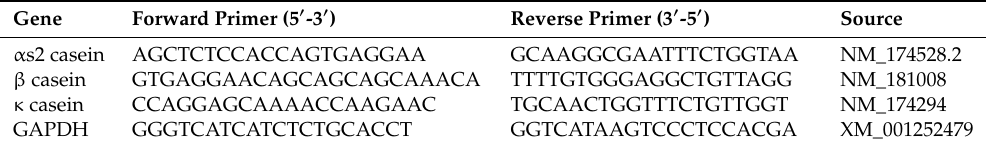
Table 1. Oligonucleotide primer sets for real-time